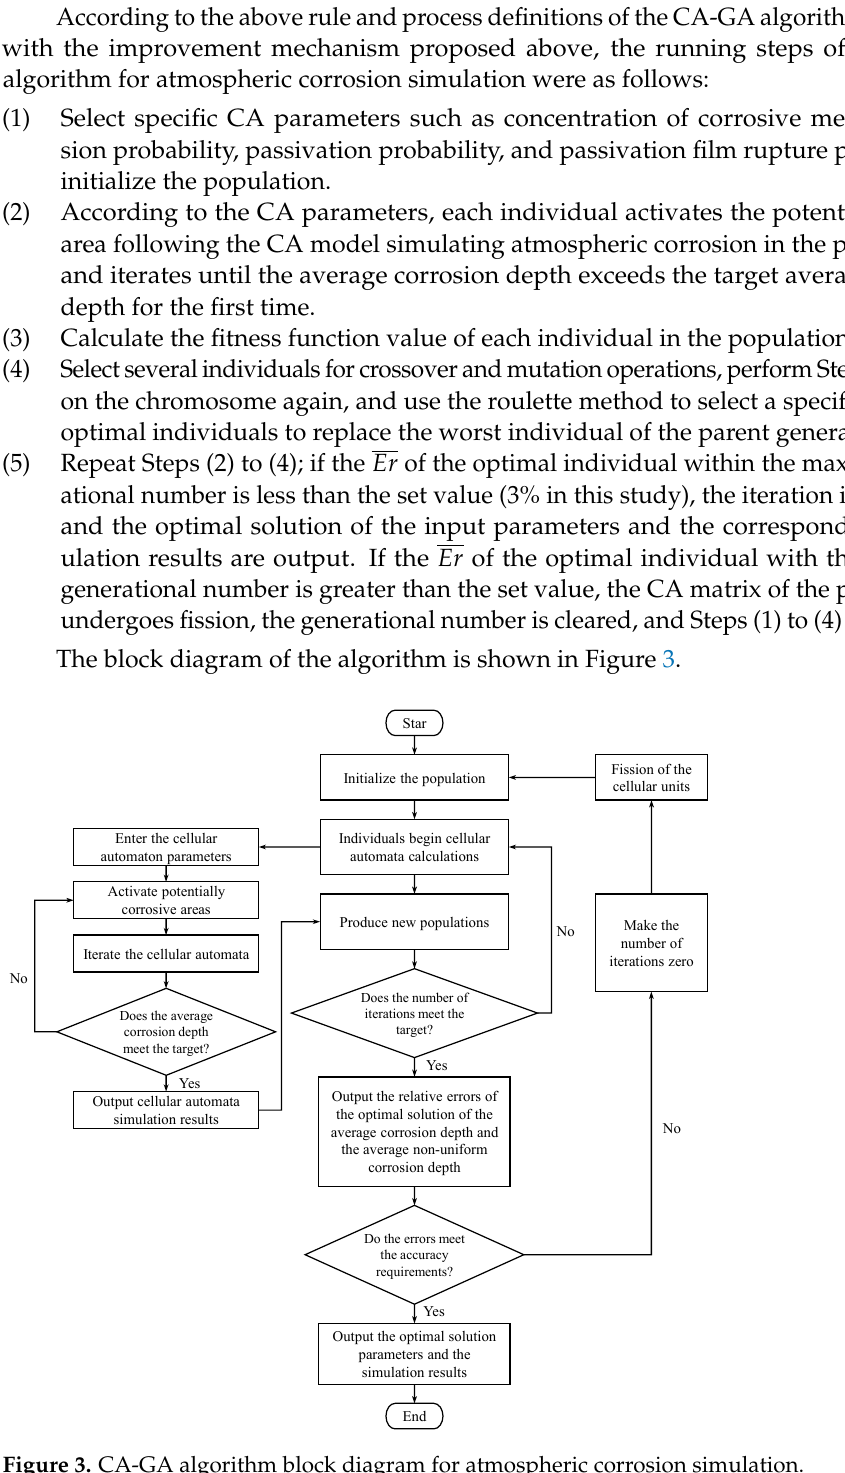
Figure 3. CA-GA algorithm block diagram for atmospheric corrosion simulation.